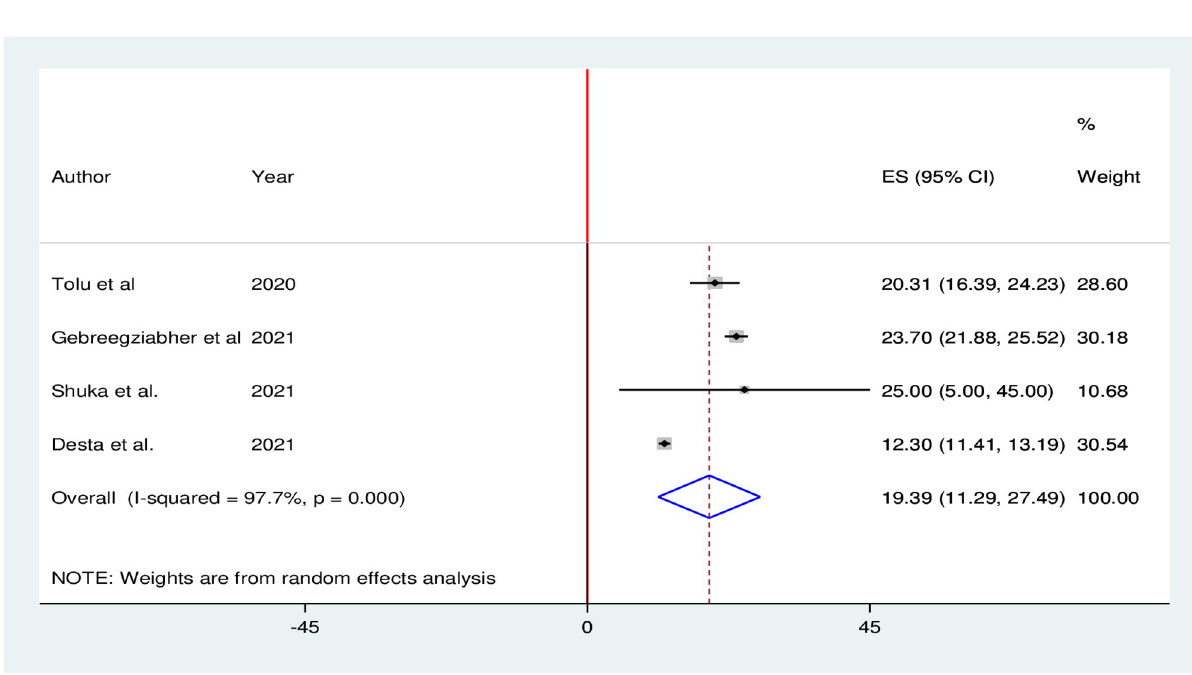
Fig 12. Forest plot of the pooled reduction of abortion care services utilization during COVID-19 pandemic in Ethiopia, 2021.